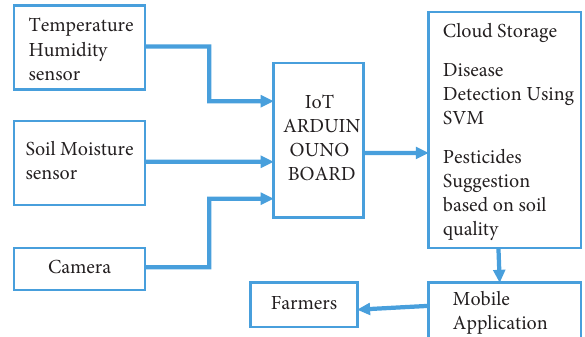
Figure 1: An IoT-based framework for smart